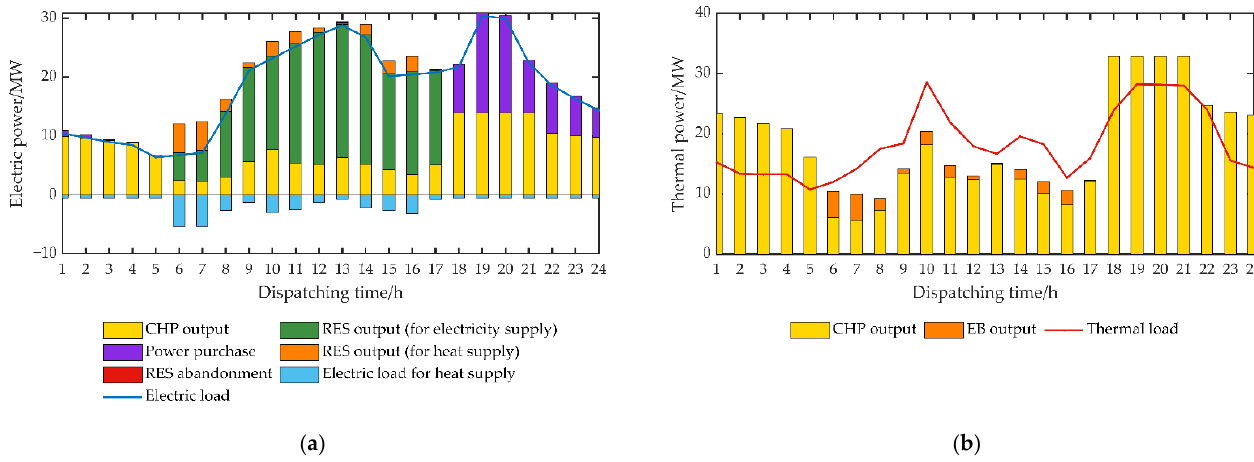
Figure 8. Independent dispatching in the commercial area: ( a ) Electric power; ( b ) Thermal power.